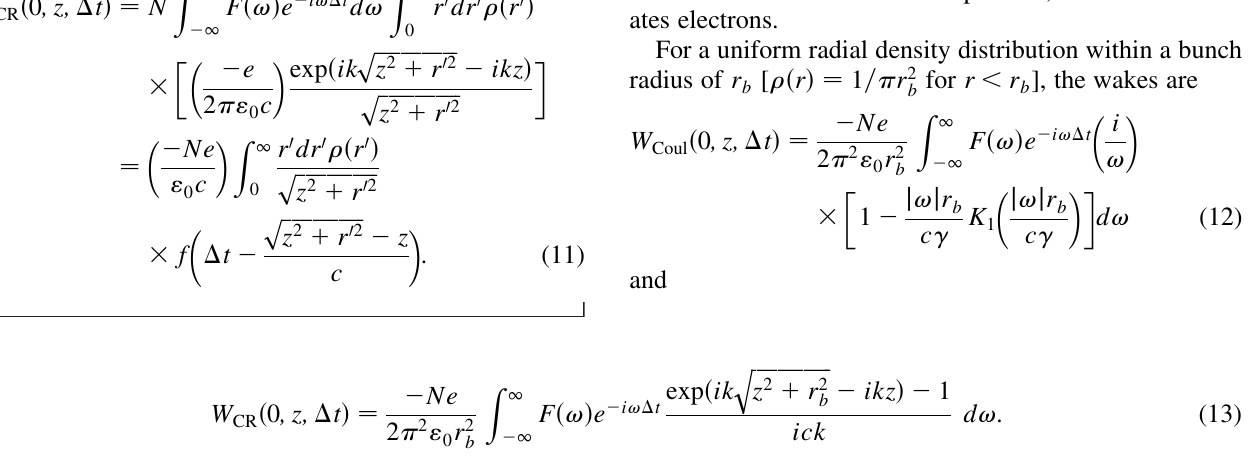
FIG. 1. (Color) For bunches with a Gaussian temporal distribu- tion, the coherent-radiation wake of suddenly accelerated elec- trons is computed numerically from Eq. (15) and approximated by Eq. (17). The wakes are computed for four values of the axial coordinate z , and normalized to the height of the approximate wake given by Eq. (17). Here, a negative wake corresponds to energy loss; a positive (cid:1) t describes the tail of the bunch. (a) r (cid:6) 3 (cid:7) (cid:6) 10 (cid:7) (cid:7) . (b) r . (c) r z b z b z